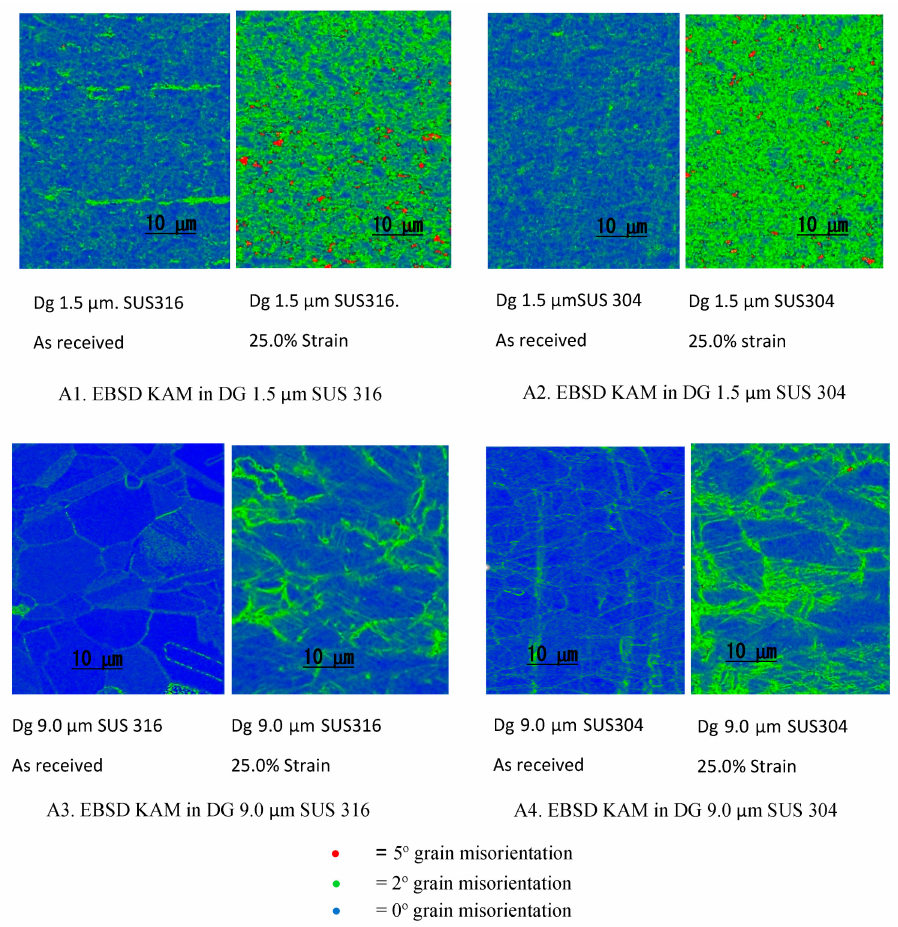
Figure 9. KAM mapping for SUS 304 and SUS 316 thin metal